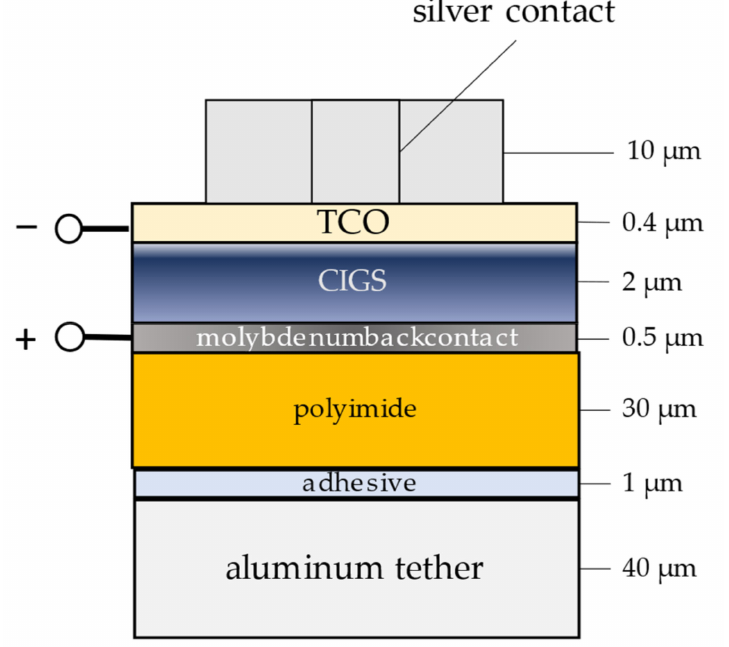
Figure 1. PTS layering: The solar cells consist of a transparent conductive oxide (TCO) layer as a front contact, the Copper–Indium–Gallium–Selenide (CIGS) absorber material and a molybdenum back contact. The front contact is supported by a silver electron collecting grid. The cells are grown on a polyimide substrate, which is applied to a bare aluminum tether, using an adhesive transfer tape; dimensions are not to